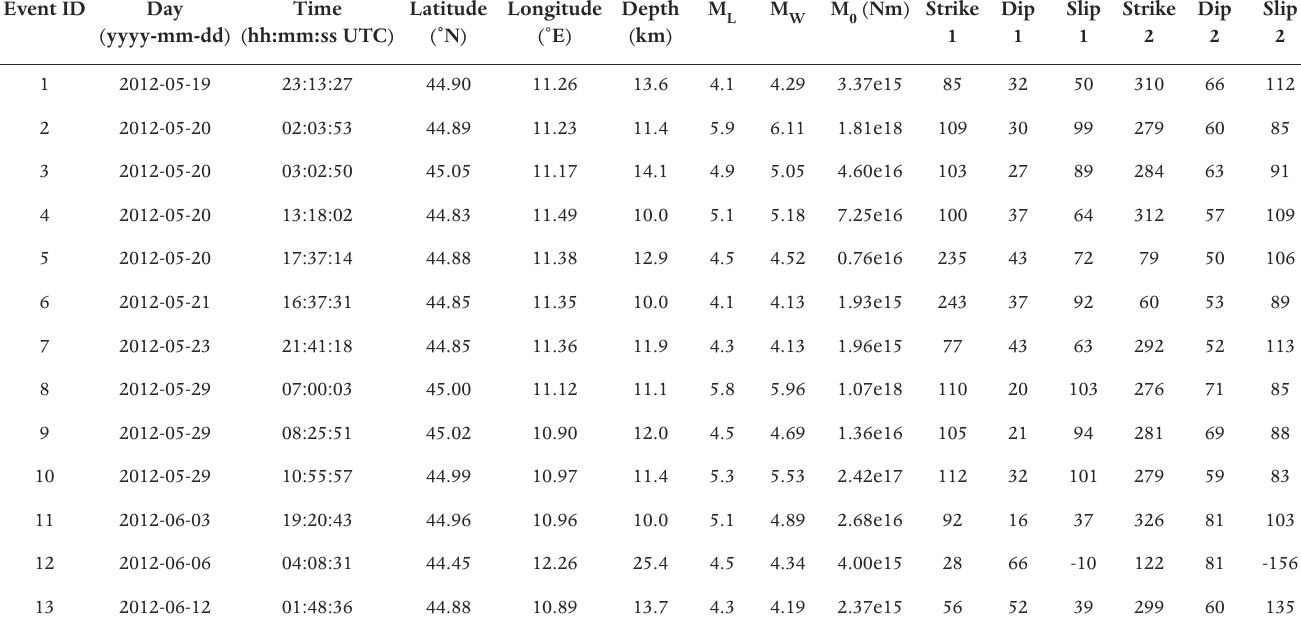
Table 1. Source parameters for the events of the Emilia sequence for which a QRCMT was